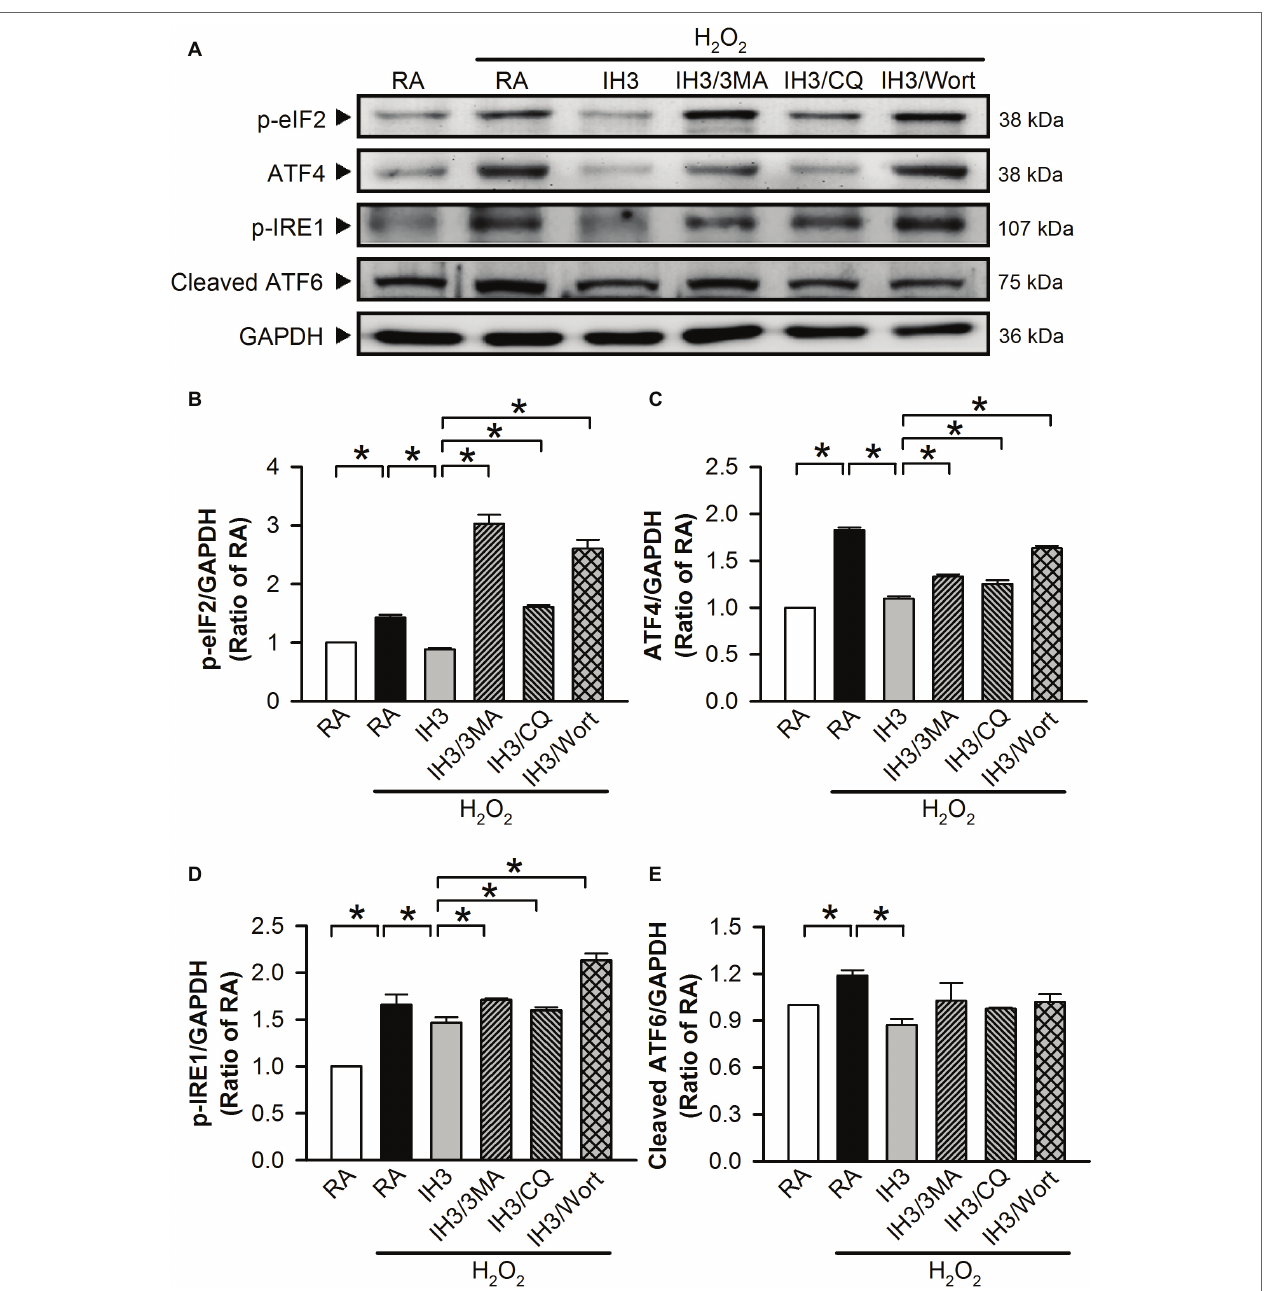
FIGURE 5 | IH attenuates autophagy-associated ER stress through the p-elF2 and p-IRE1 signaling pathway in H9c2 cells. (A) Cells were treated with RA or IH for 3 days followed by H 2 O 2 alone, H 2 O 2 combined with 3-methyladenine (50 μM), H 2 O 2 combined with chloroquine (5 μM), or H 2 O 2 combined with wortmannin (5 nM) for additional 24 h, and then harvested for detecting the ER stress-related protein levels. (A) A representative result of p-eIF2, ATF4, p-IRE1, cleaved ATF6, and GAPDH protein levels determined by Western blot analyses. Quantitative results shown in (B) for p-eIF2 protein levels, (C) for ATF4 protein levels, (D) for p-IRE1 protein levels, and (E) for cleaved ATF6 protein levels were adjusted with GAPDH protein level and expressed as ratio over the RA group. Values are means ± SEMs. ( n = 4). * p < 0.05. 3MA, 3-methyladenine; CQ, chloroquine; IH, intermittent hypoxia; RA, room air; Wort,